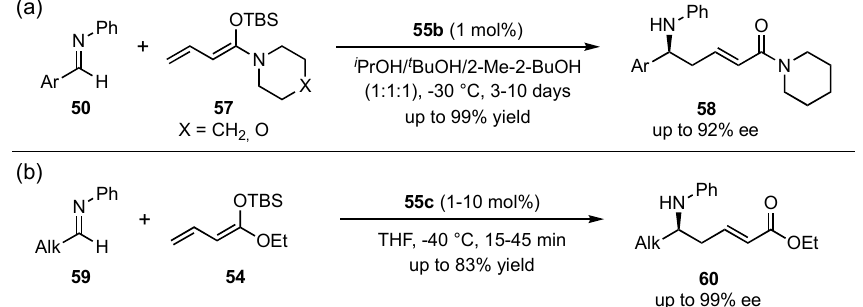
Scheme 16. Investigation of linear vinylketene silyl N , O -acetals in Brønsted acid organocatalyzed asymmetric VMMnRs ( a ) and optimization in the utility of aliphatic substrates ( b ) by Schneider et al. [50,52].